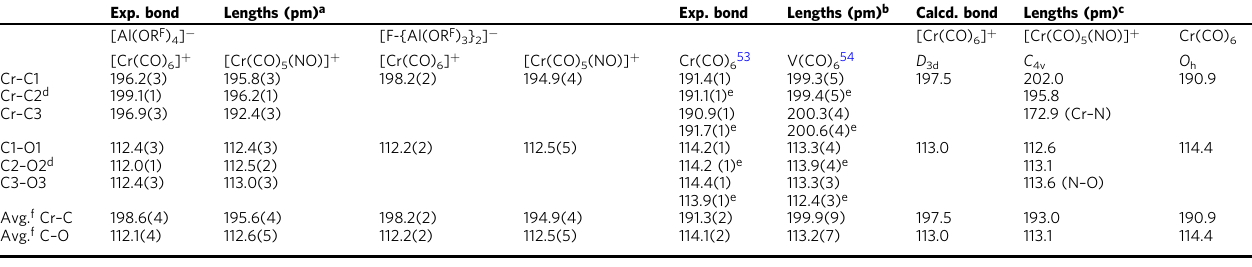
Table 3 Comparison of experimental (exp.) and theoretical (calcd.) bond lengths of 1 – 4 and selected literature complexes Exp.